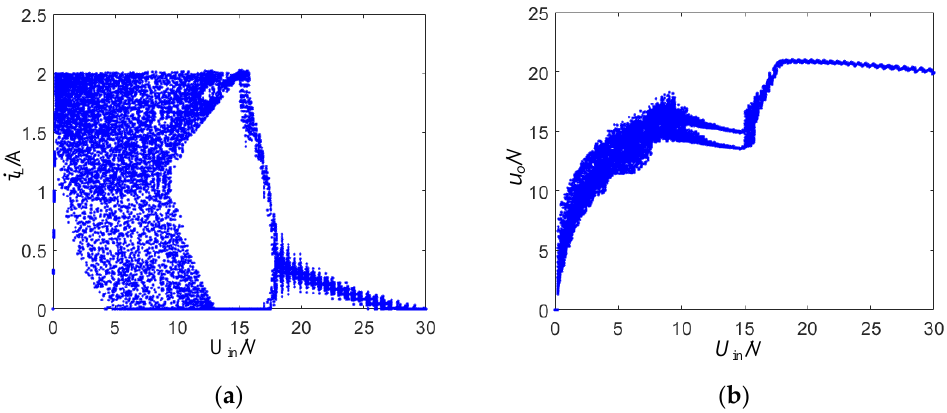
Figure 6. A bifurcation diagram of the FO DCM buck – boost converter with U in as the parameter: ( a )